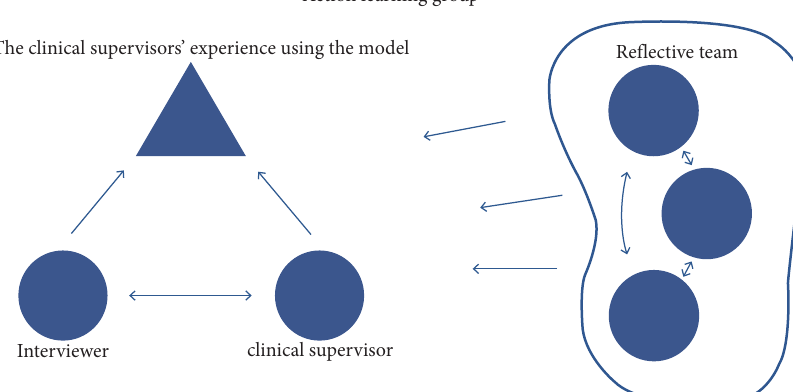
Figure 1: Structured reflection process in the action learning